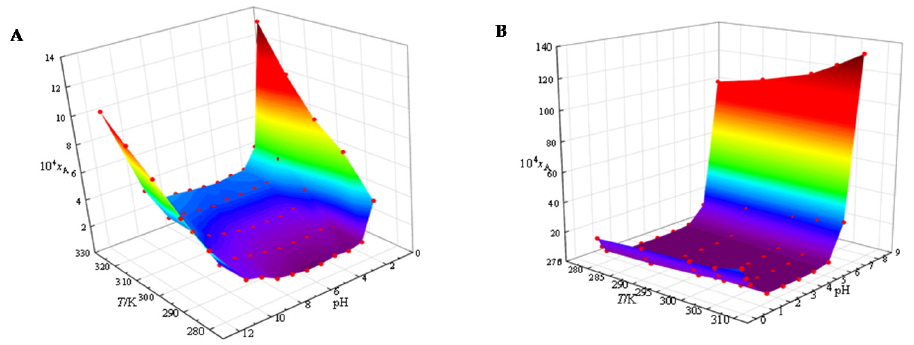
Figure 4. Solubility of 7-ADCA ( A ) and phenylglycine ( B ) in water at temperature (283.15–323.15 K) and pH (1.00–8.00).